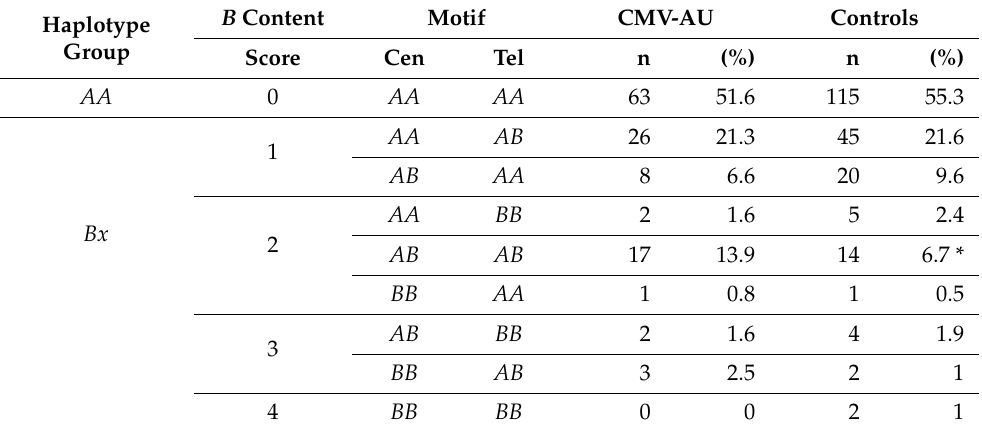
Table 1. Comparison of B -content score-based KIR haplotype motifs between CMV-AU and healthy controls. B Haplotype Group